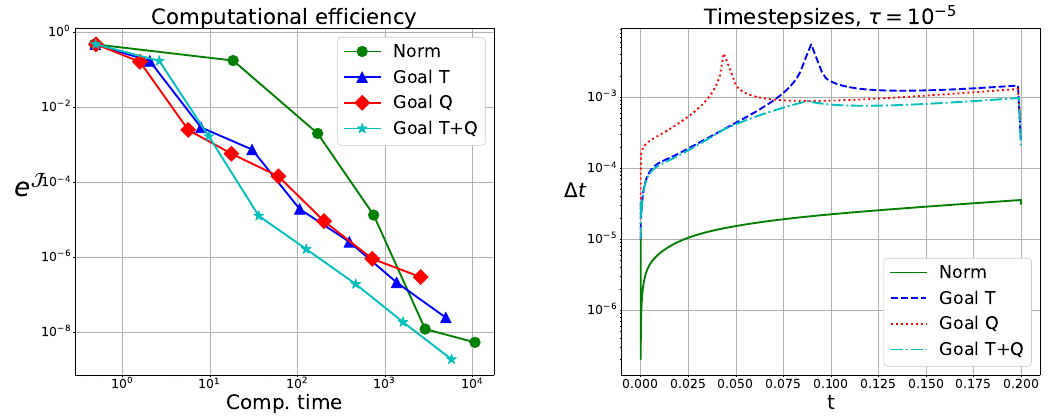
Figure 6. Comparison of the local error based adaptive methods for the coupled heat